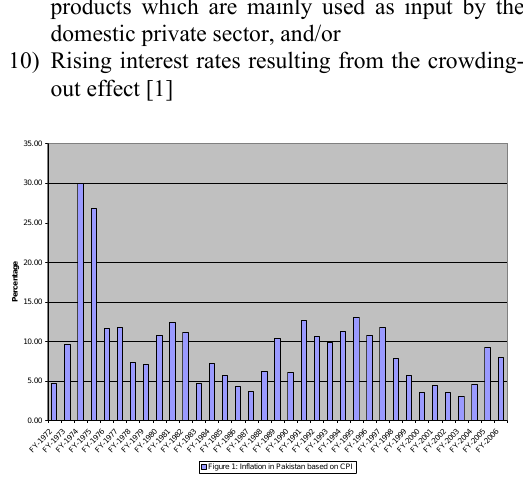
Figure 1: Source: Hand Book of Statistics on Pakistan Economy-2005 by State Bank of